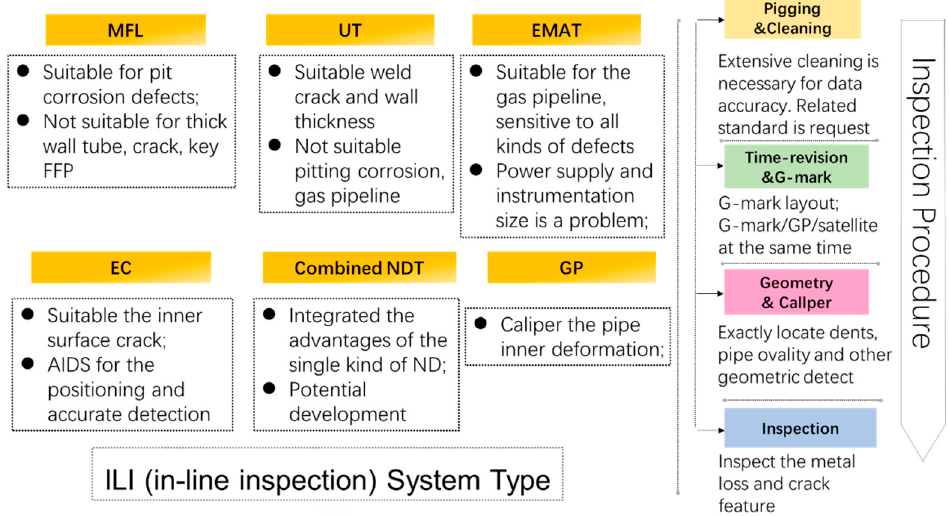
Figure 2. Structure schematic of internal inspection (ILI) system. Reprinted from ref. [110].